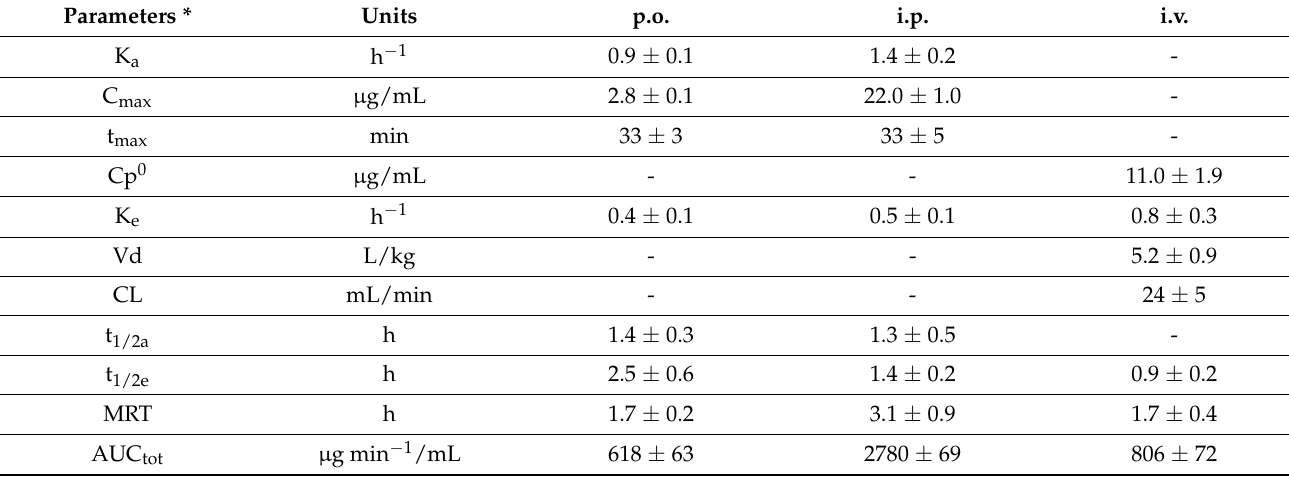
Table 4. Plasma pharmacokinetic parameters of C1 in rats, determined by non-compartmental model analysis after a single i.v., i.p., and p.o. dose of 50, 75, or 50 mg/kg, respectively. Data are expressed as the mean ± SD ( n = 6). Data are expressed as the mean ± SD ( n =